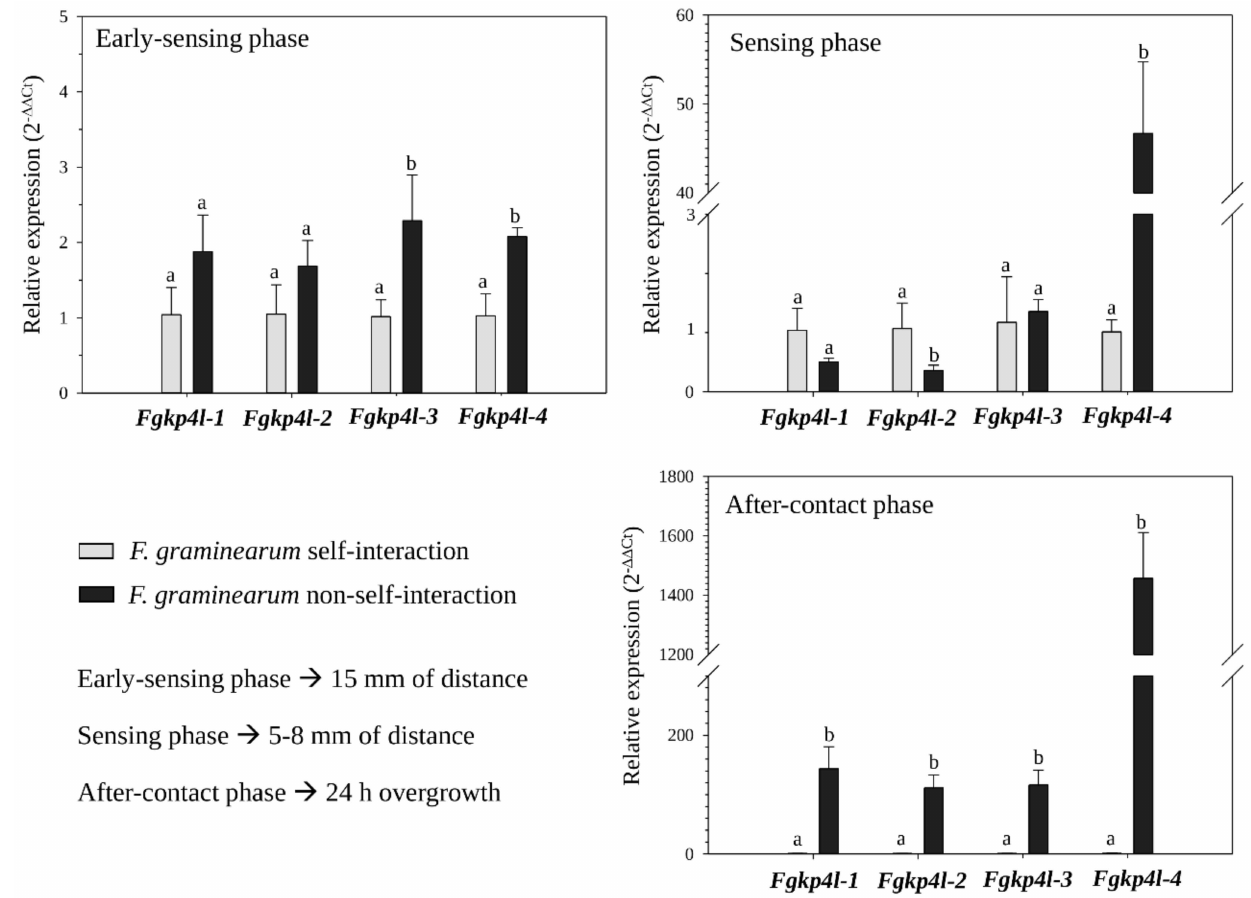
Figure 1. Gene expression profiles of Fgkp4l genes in dual cultures with T. gamsii . Total RNA was extracted from mycelium of F. graminearum grown on PDA vs. itself (self-interaction, basal